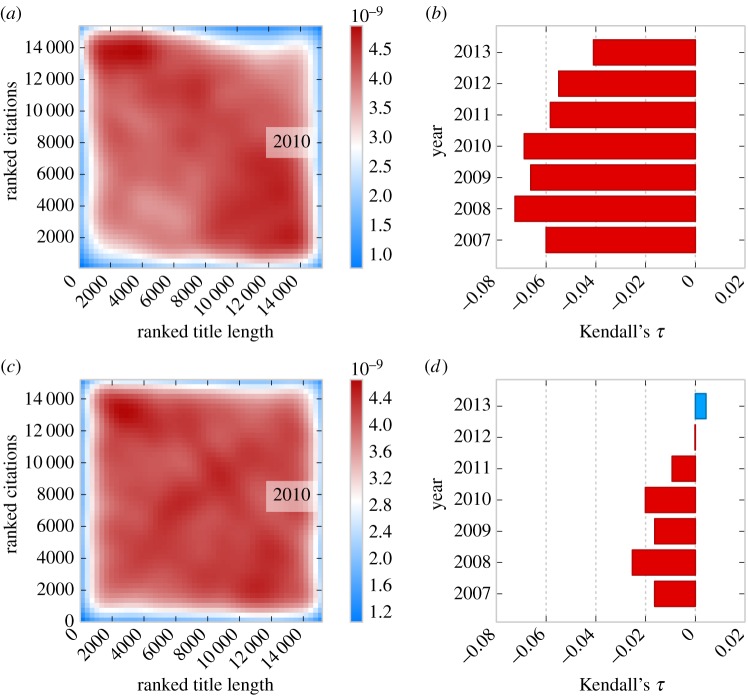
Paper title length and citations received. (a) We consider the 20 000 most cited papers in 2010. We rank the papers both in terms of citations received and title length. A density plot of the ranked citations and title length reveals that papers with shorter titles receive more citations (Kendall's τ=−0.07, N=15 395, p<0.001). (b) We run parallel analyses for the 20 000 most cited papers in each year between 2007 and 2013. For each of these years, we find that papers with shorter titles receive more citations (all τs <−0.042, all ps <0.001, α=0.05, Kendall's τ correlation with FDR correction). (c) To remove any potential influence of the journal in which a paper is published on this relationship, we rank all of the papers in terms of the number of citations received and transform these ranks into percentiles. We calculate percentiles in terms of the length of papers' titles in the same fashion. In this transformed data, we find that papers with shorter titles receive more citations in 2010 (Kendall's τ=−0.020, N=15 395, p<0.001). (d) We run parallel analyses for the 20 000 most cited papers in each year between 2007 and 2013. For years 2007–2010, we find that papers with shorter titles receive more citations, whereas papers published during 2011–2013 do not (for years 2007–2010, all τs <−0.016, all Ns >14 791, all ps <0.01; for years 2011–2013, all |τ|s <0.01, all Ns >15 396, all ps >0.05; Kendall's tau with FDR correction). The smaller τs in (d) suggest that the journal in which a paper is published may help explain the relationship between paper title length and the number of citations the paper receives.